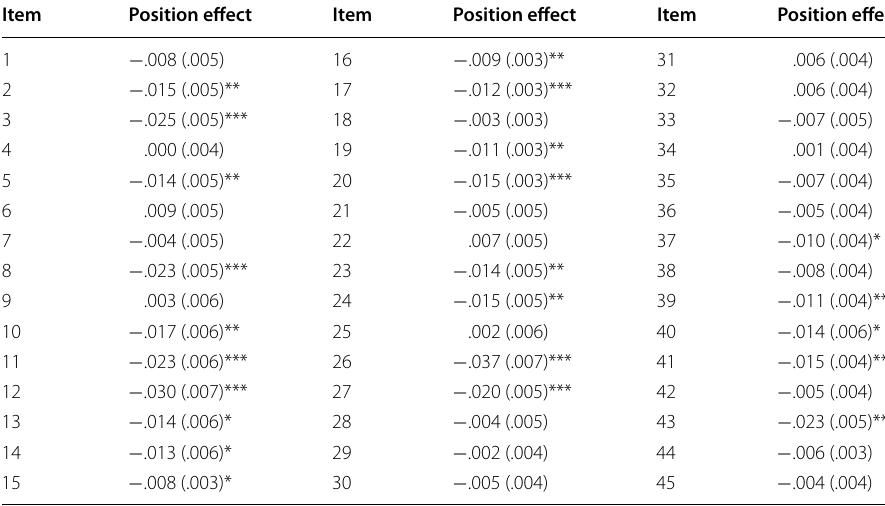
Table 5 Summary of estimated item position